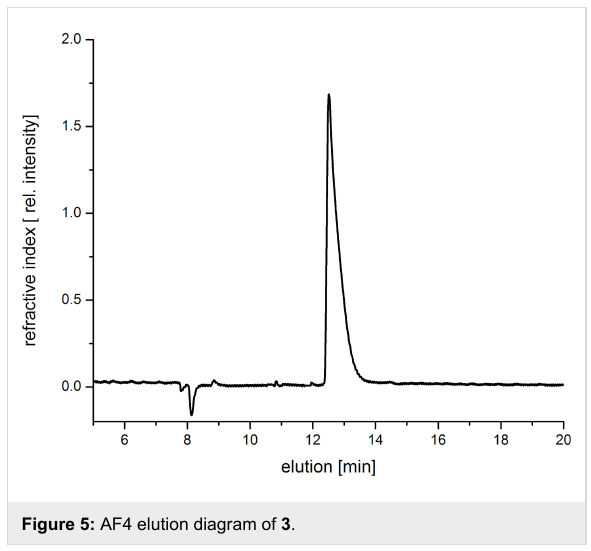
Figure 5: AF4 elution diagram of 3